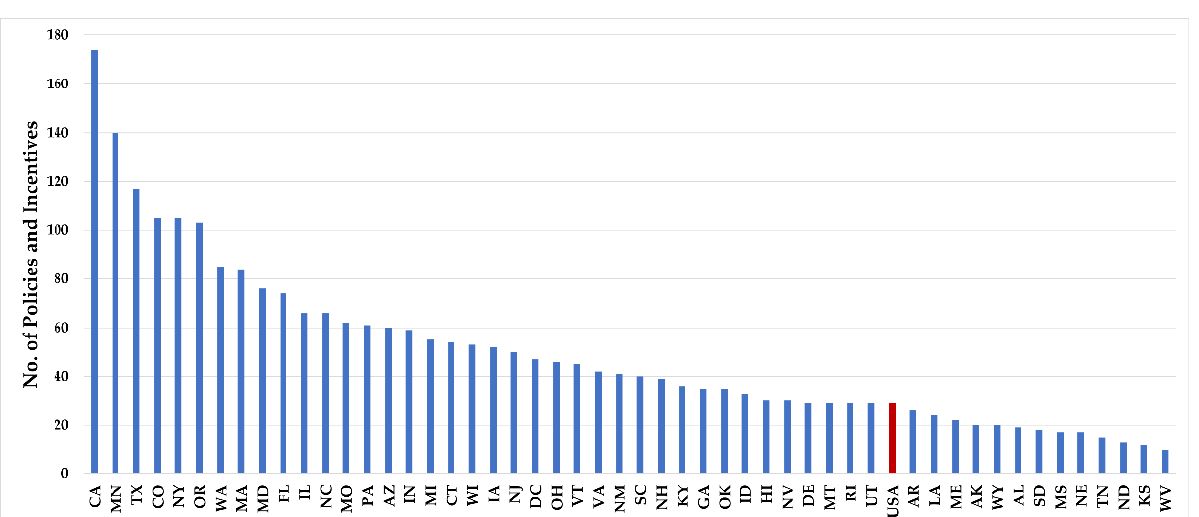
Figure 2. Number of policies and incentives by US state. The enacted policies vary by state, with California having the highest number of policies (176) and West Virginia having the lowest number of policies (10). The federal government, highlighted in red, is ranked 39 with 29 policies (data source: [45]).